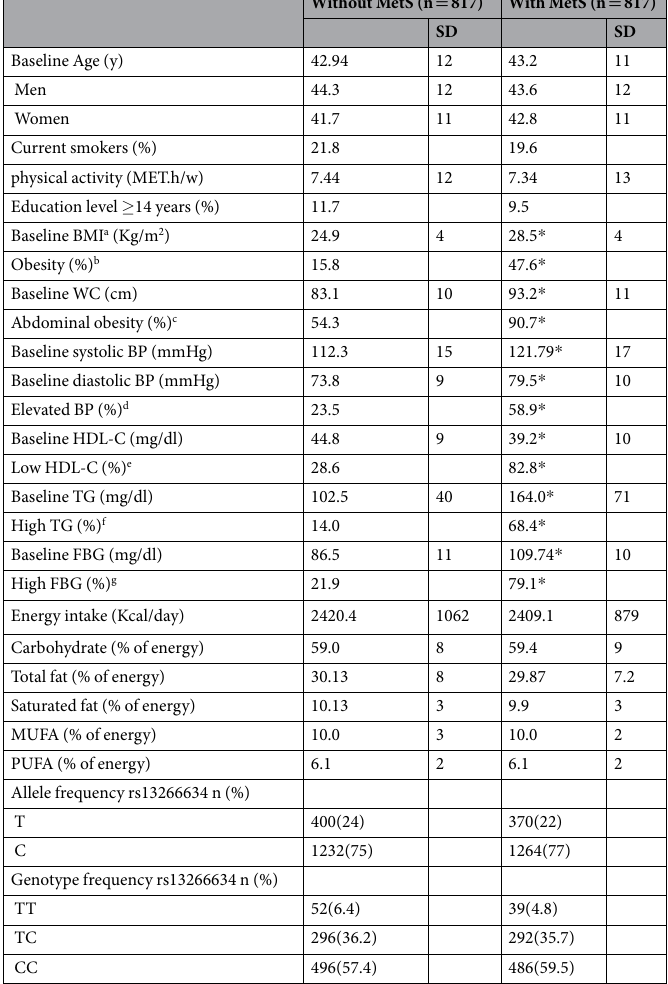
Table 1. Characteristics of the study population in subjects with MetScases and controls. BMI: body mass index. WC, waist circumference. BP. blood pressure. HDL-C. high density lipoprotein cholesterol. TG: triacylglycerol. FBG, fasting blood glucose, MUFA, Mono-unsaturated fatty acids. PUFA, Poly-unsaturated fatty acids * P < 0.05; † values are mean unless otherwise listed. a Baseline BMI at the first or second phase